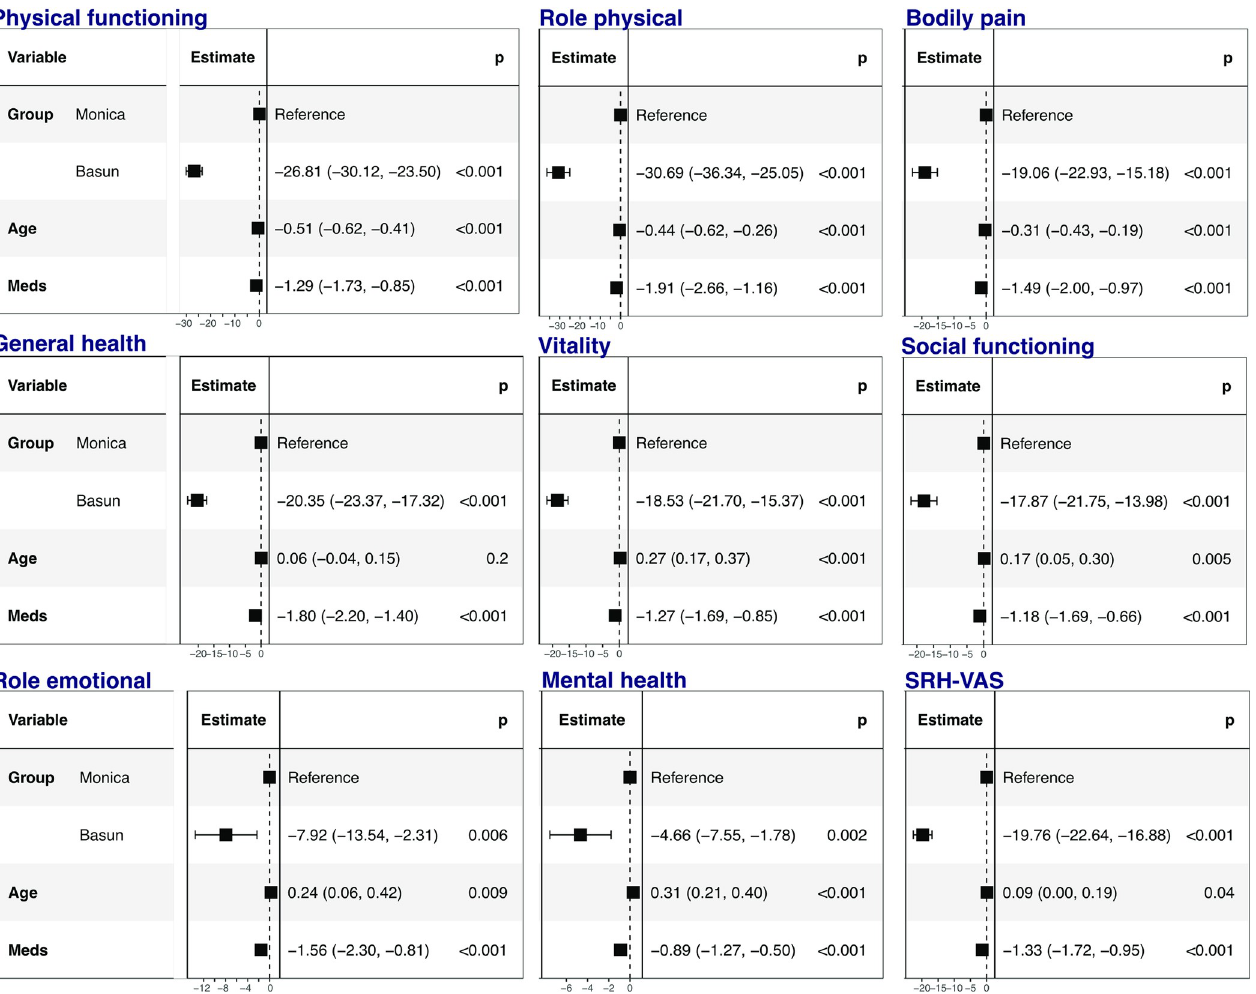
Fig 1. Results from a multiple linear regression for evaluation of association between health-related quality of life indicated by the Rand-36 and SRH-VAS instruments and weight category (BASUN population with obesity and reference MONICA population). The model is adjusted for age and number of medication (Meds) and results presented as beta coefficients with 95% confidence